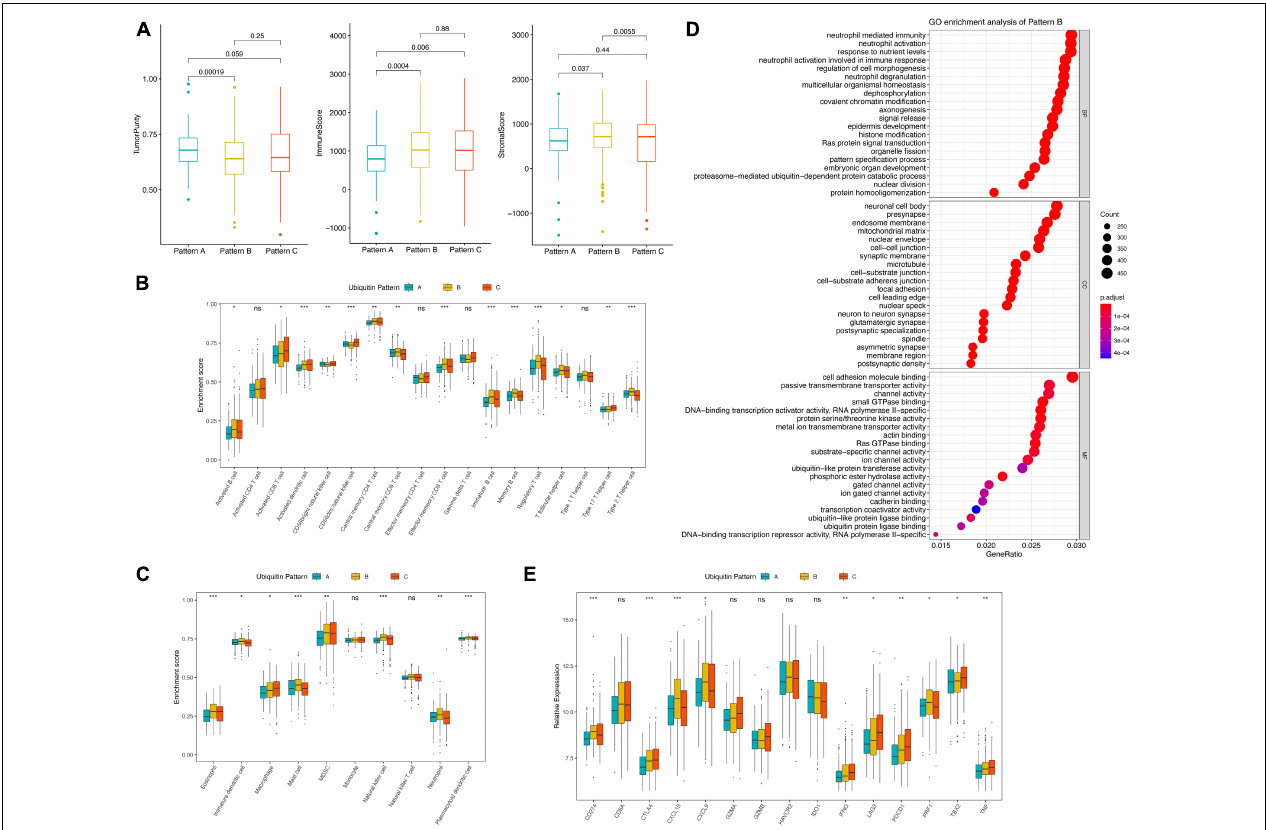
FIGURE 3 | TME features of distinct ubiquitin patterns. (A) Tumor purity, immune score, and the stromal score of the subclasses generated by the “ESTIMATE” algorithm. The comparison was performed by Student’s t -test. (B,C) Estimated abundance of 18 adaptive and 10 innate immune cells using ssGSEA. Inter-subgroup comparison was performed by one-way ANOVA. (D) GO enrichment results of pattern B. The Top 20 of biological process (BP), cellular component (CC), and molecular function (MF) were displayed. (E) Association of ubiquitin patterns with immune checkpoint molecules. Kruskal–Wallis test, ns, no statistical difference, * p < 0.05, ** p < 0.01, *** p <